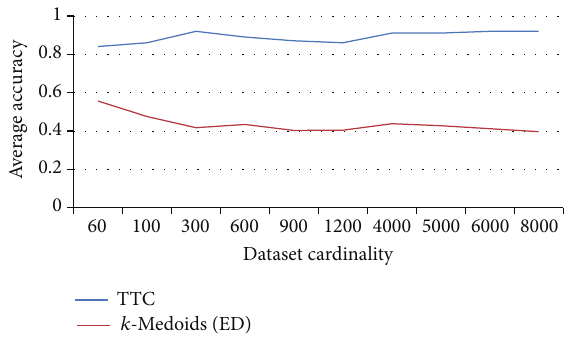
Figure 8: Accuracy of TTC across different CBF dataset sizes.